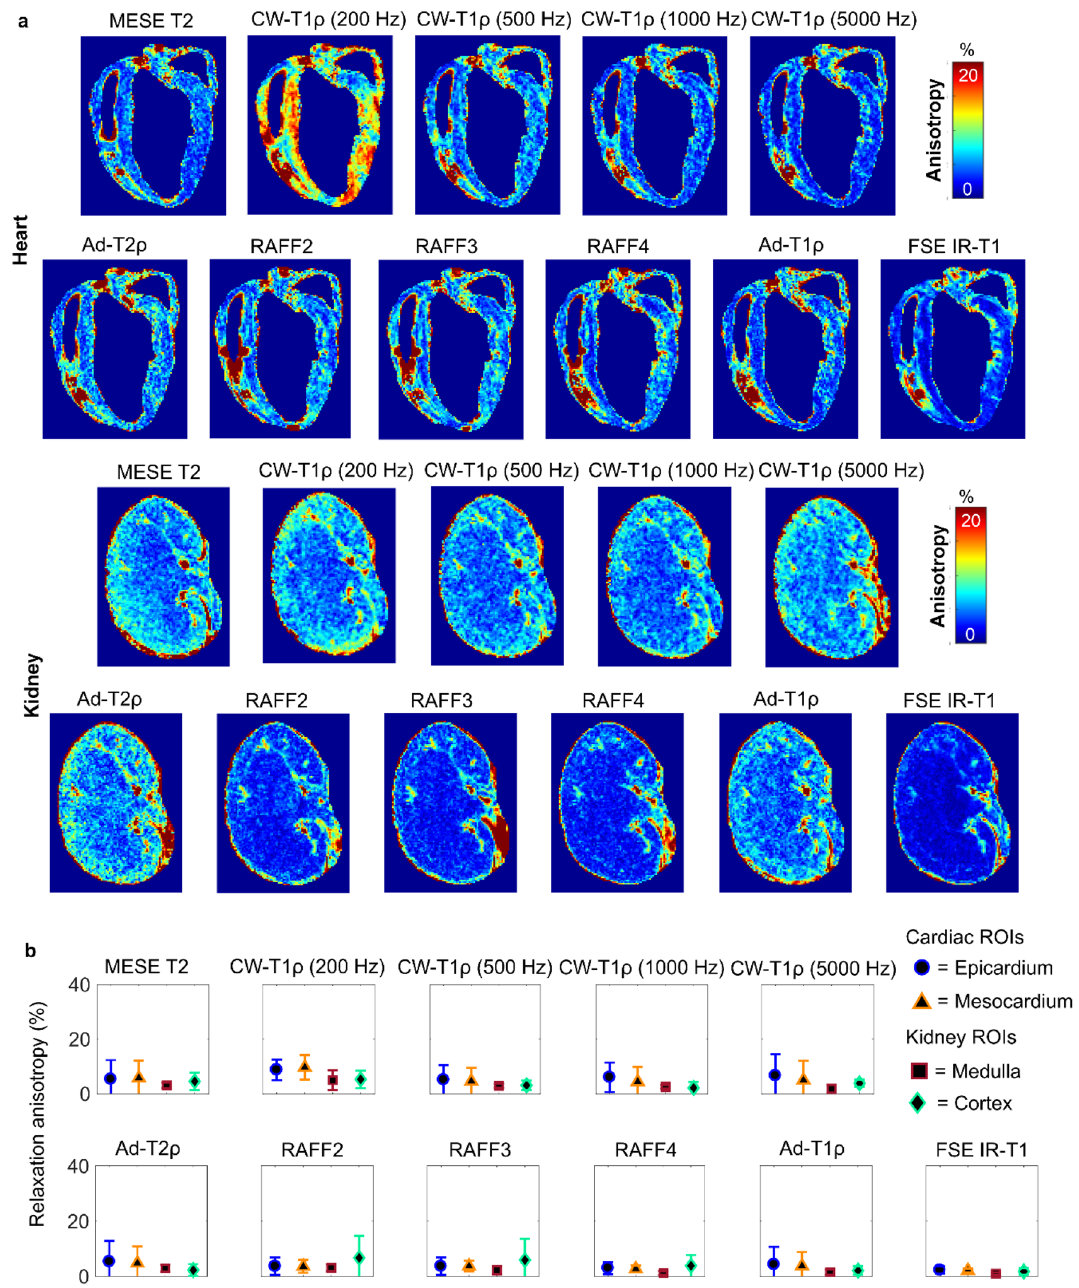
Figure 6. ( a ) Relaxation anisotropy maps of quantitative MRI parameters in heart and kidney samples. ( b ) Average relaxation anisotropy in the ROIs defined as shown in Fig.